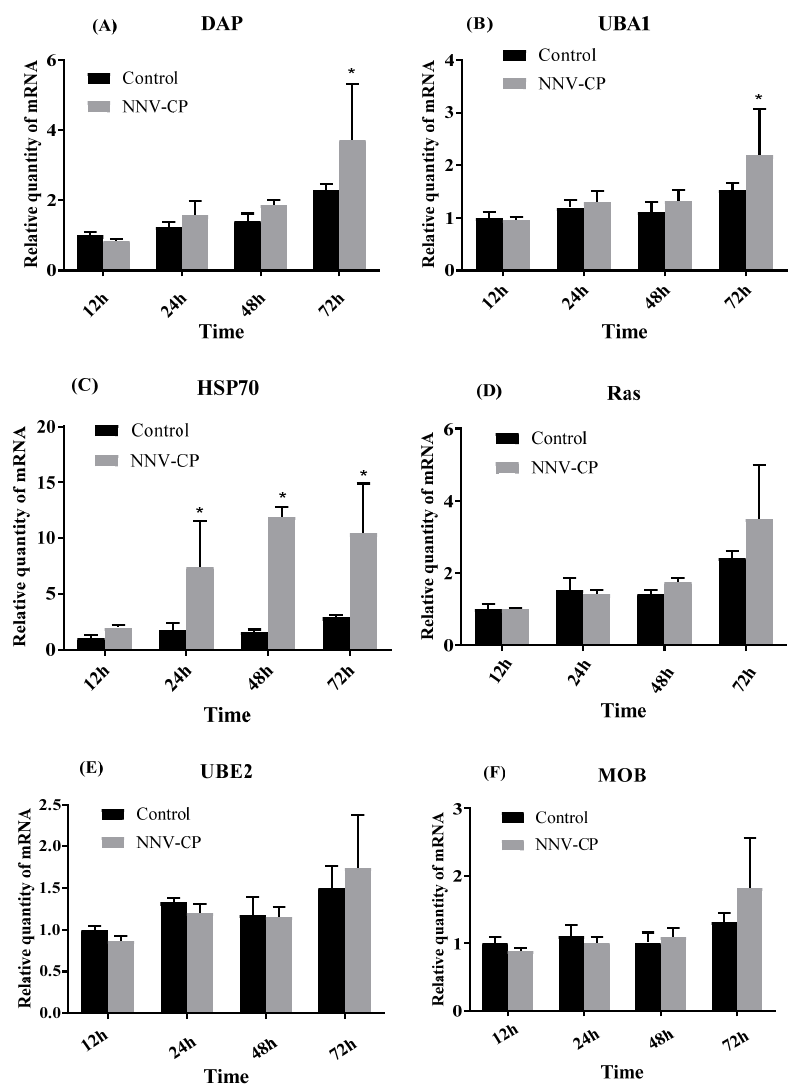
Figure 5. Transcriptional levels of DAP ( A ), UBA1 ( B ), HSP70 ( C ), Ras ( D ), UBE2 ( E ) and MOB ( F ) after pEGFP-CP transfection (*: p < 0.05).